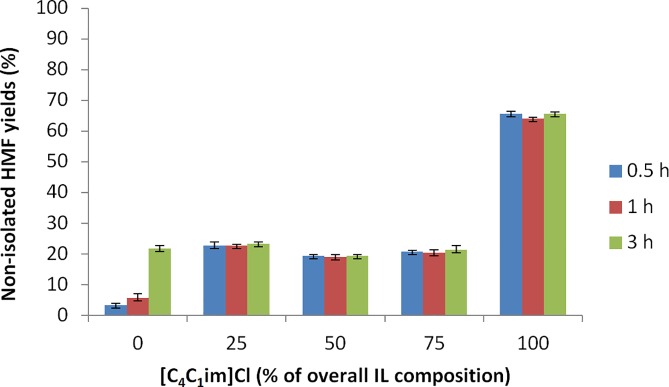
HMF yield from glucose in pure [C4C1im]Cl and mixed with [C4C1im][HSO4] at 120°C.0.1 g glucose in 0.7 g ionic liquid, 7 mol% CrCl3·6H2O catalyst. Reported yields are non-isolated.